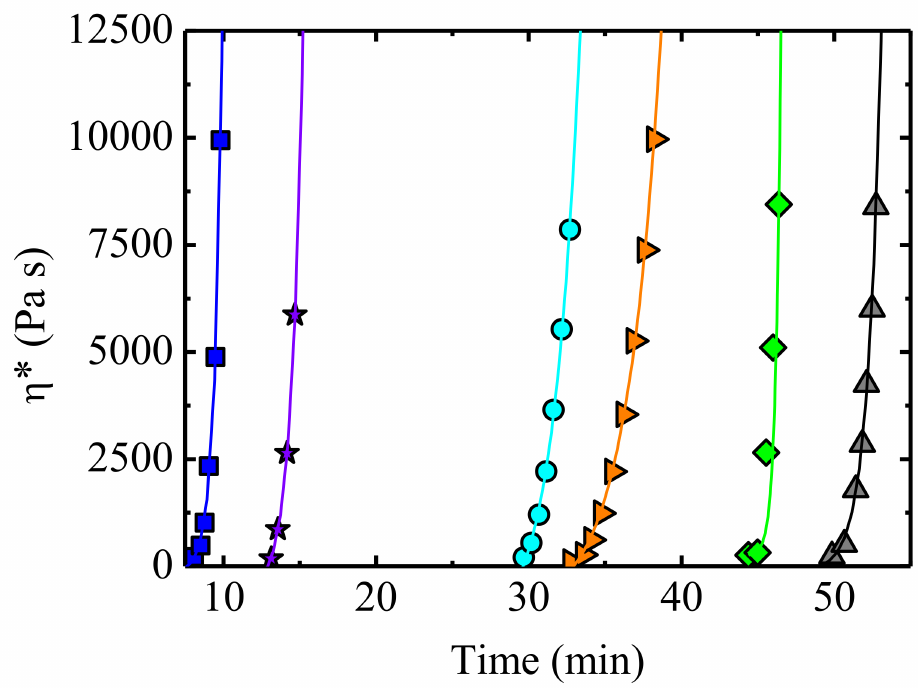
Figure 7. Complex viscosity as a function of time for different DGEBA/MXDA formulations. Square neat = DGEBA/MXDA, star = 5 wt % PSEO (block copolymer), circle = 5 wt % PSEO and 30 wt % HBC (liquid crystal), inverse triangle = 30 wt % HBC, diamond = 5 wt % PSEO and 50 wt % HBC, and triangle = 50 wt % HBC. Gelation times are obtained from the asymptotes (see text) [72] Reprinted with permission from [72] Copyright 2008 Acta Materialia Inc. Published by Elsevier